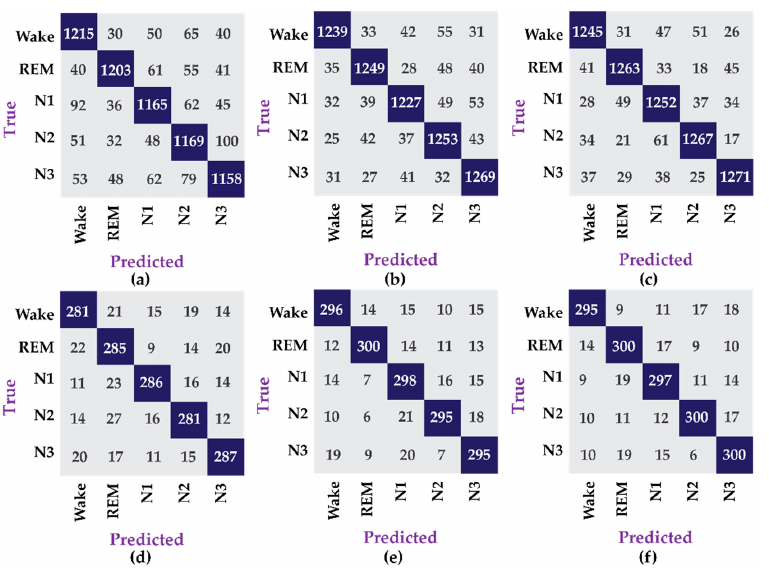
Figure 6. Training loss curve comparisons for different datasets. 4.2. Comparisons and Discussion The proposed approach is compared with the following eight techniques using the same datasets: (1) Raw EEG + ResNet: this approach uses the raw multi-channel EEG signals as input to the ResNet architecture used in the proposed framework. Comparison with this technique highlights the benefit of using the PSD of the EEG signals over the raw EEG signals as input. (2) PSD + CNN (5 layers): this approach uses the same input data, i.e., PSD of raw EEG signals, but uses a 5-layer CNN instead of a ResNet. Comparison with this technique highlights the benefit of using ResNet compared to CNN.